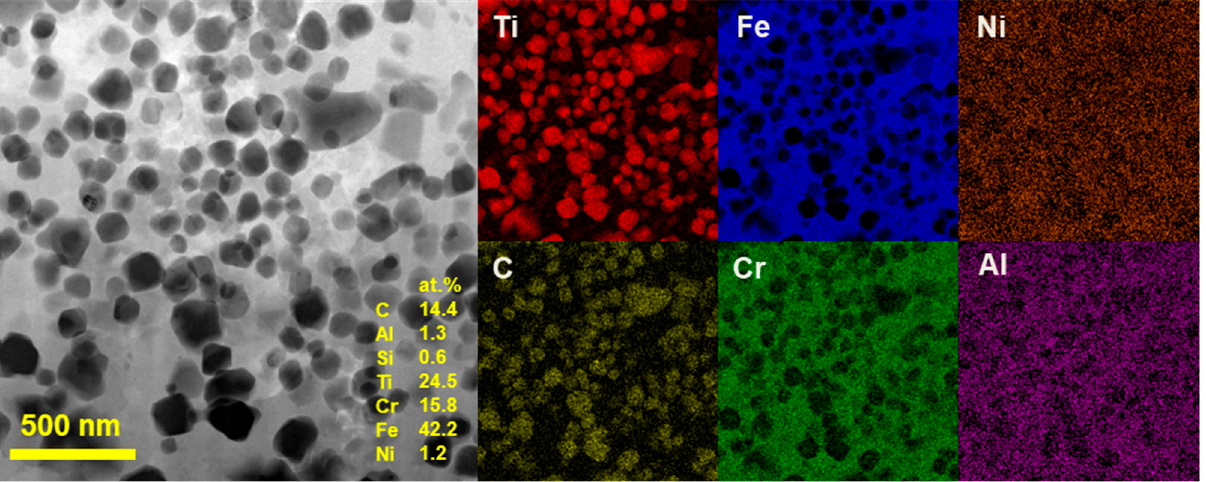
Figure 5. HAADF TEM image of 75C coating with corresponding EDS elemental maps and composition obtained from the whole area.